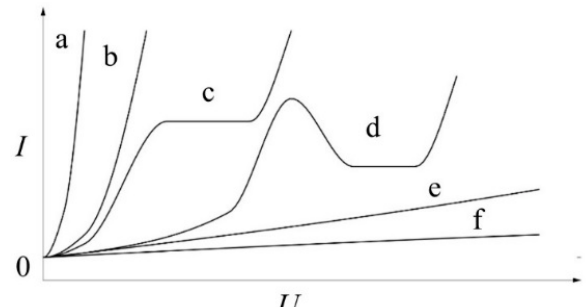
Figure 1. Principal types of the current density-potential behavior of an anodically polarized electrode in an electrolyte in accordance to Kurze [5]: a / b - dissolution, c - passivation in small potential range, d - complex behavior, e / f - passivation.